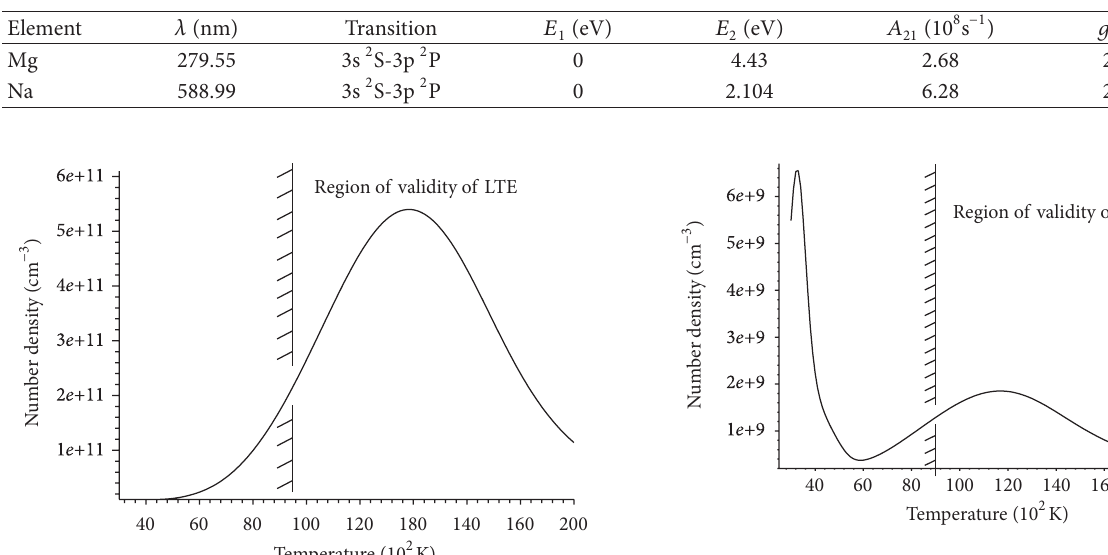
T 1: Atomic data of MgII and NaI lines [22].